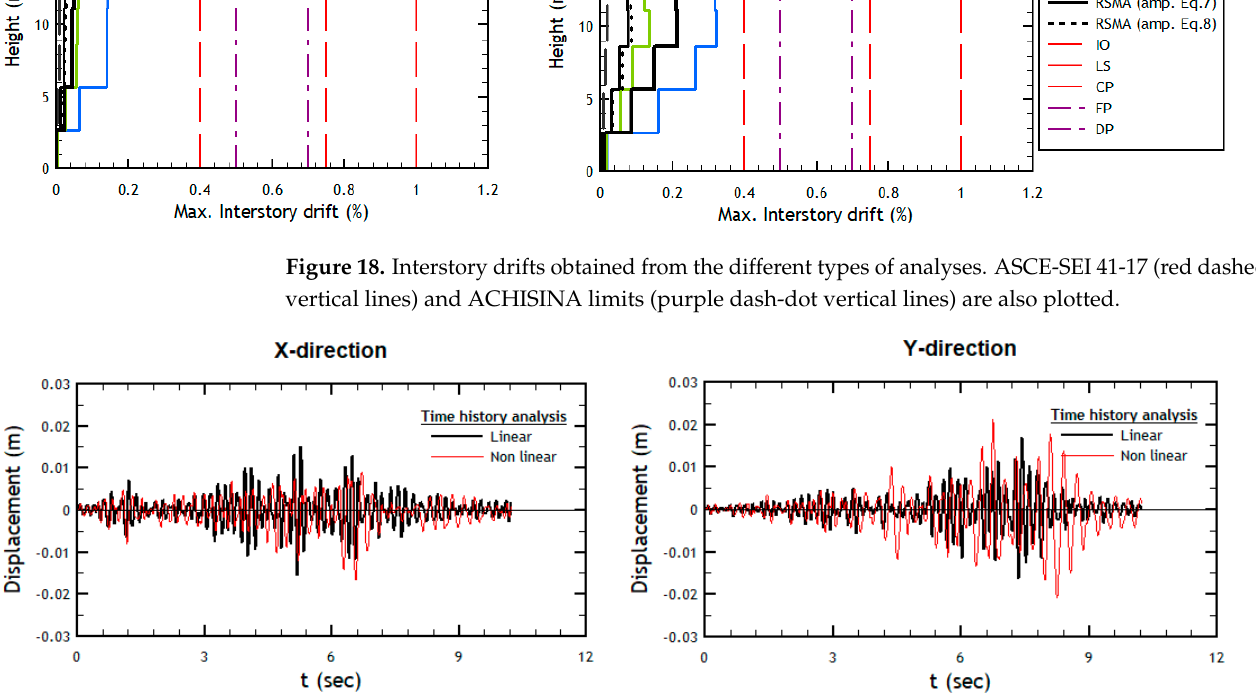
Figure 19. Comparison of top displacements achieved under the Valparaiso earthquake (24 April 2017, registered in Torpederas Station).